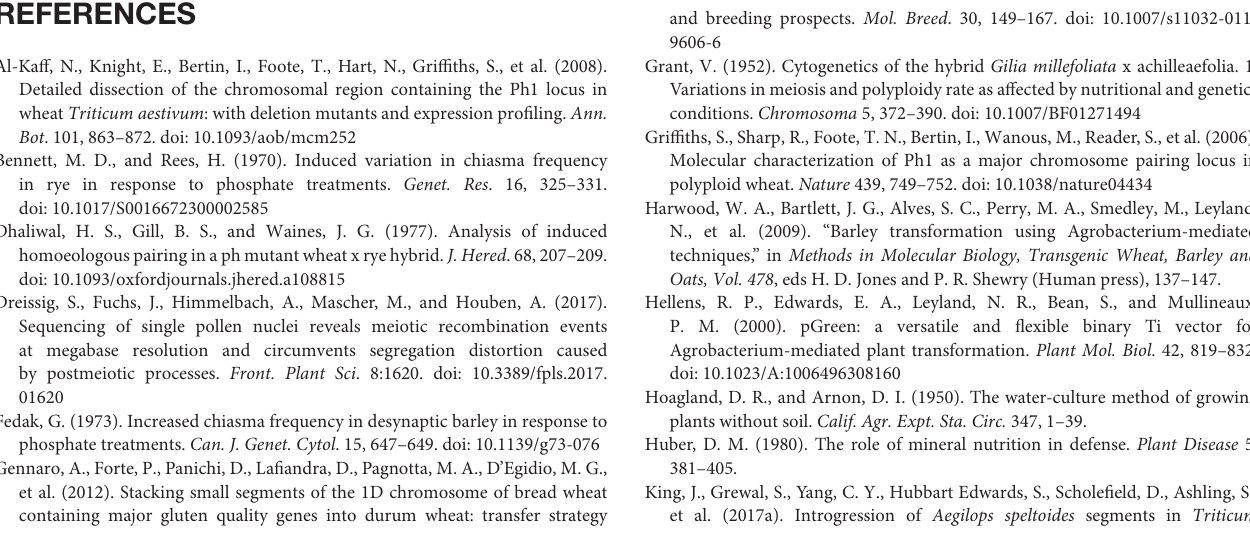
Figure S1 | Chromosomal configurations with single chiasma or double chiasmata highlighted with arrows. These structures marked by an arrow were counted as either single or double chiasmata in all analyzed meiocytes. Both datasets are shown in all analyzed genotypes. Bar: 20 µ m. Figure S2 | Representative meiotic configurations of Triticum aestivum cv. Cadenza (Cad1691- Tazip4-B2 mutant)- Ae. variabilis (A) and Triticum aestivum cv. Cadenza (Cad0348- Tazip4-B2 mutant)- Ae. variabilis (B) and wheat Tazip4-B2 CRISPR mutant- Ae. variabilis mutant (C) hybrids. From left to right: water alone, treated with either 1mM Mg 2 + or Hoagland solution. Bar: 20 µ m. Table S1 | Genotypes and number of plants used for analyzing the effect of a nutrient solution in homoeologous CO frequency in wheat and its relative species. Table S2 | Frequencies of univalents, bivalents, multivalents and chiasma frequency (single and double chiasmata) were scored at meiotic metaphase I in